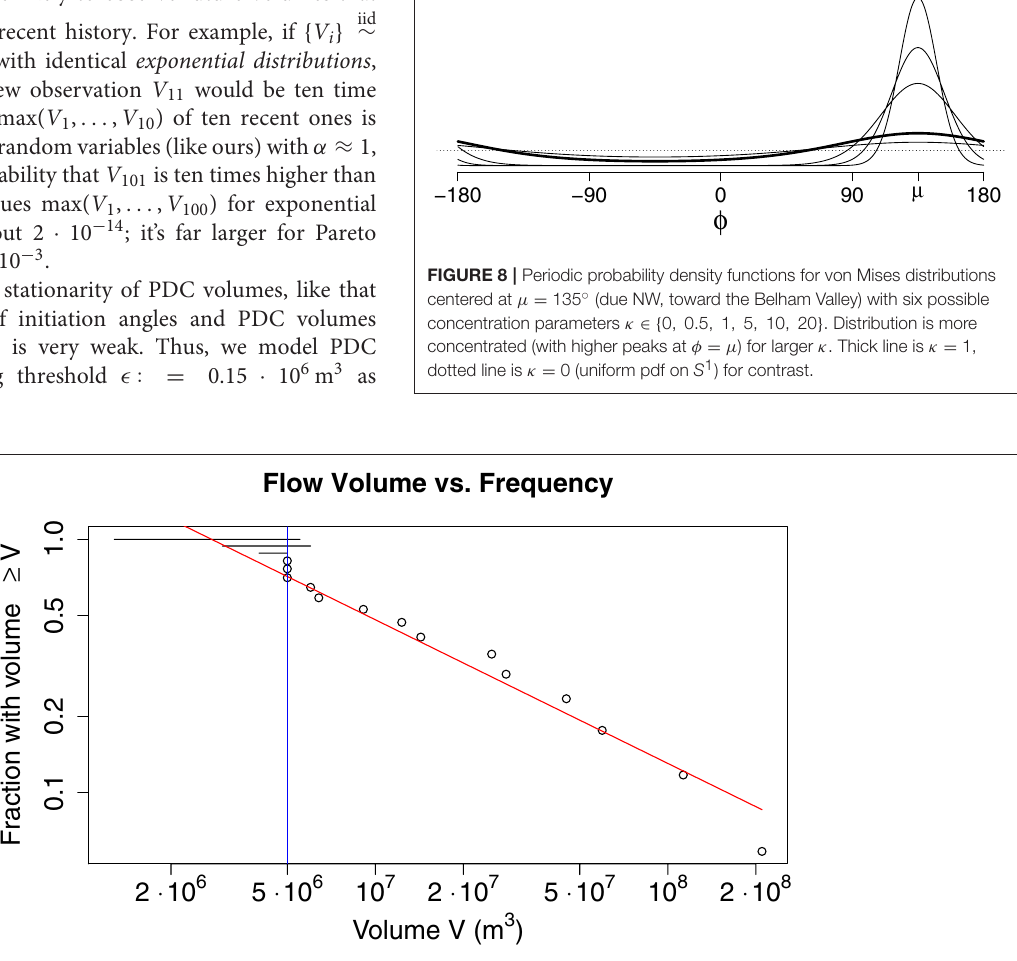
5 10 6 m 3 (shown as vertical blue line). Near linearity ≥ · 10 6 m 3 : some small volumes are reported only as ranges, indicated ·